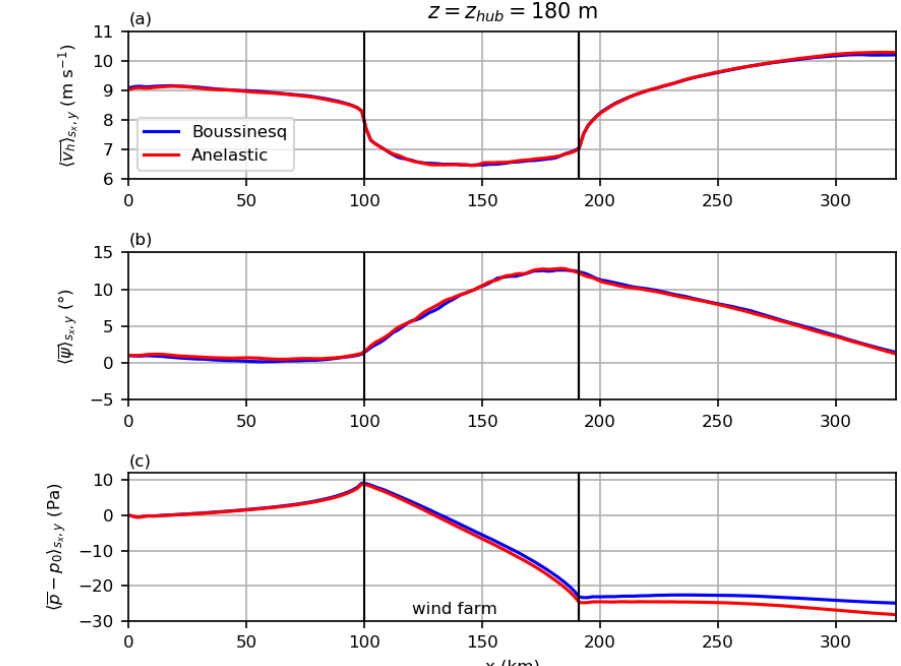
Figure A2. Horizontal wind speed, wind direction and relative perturbation pressure at hub height for both approximation types.